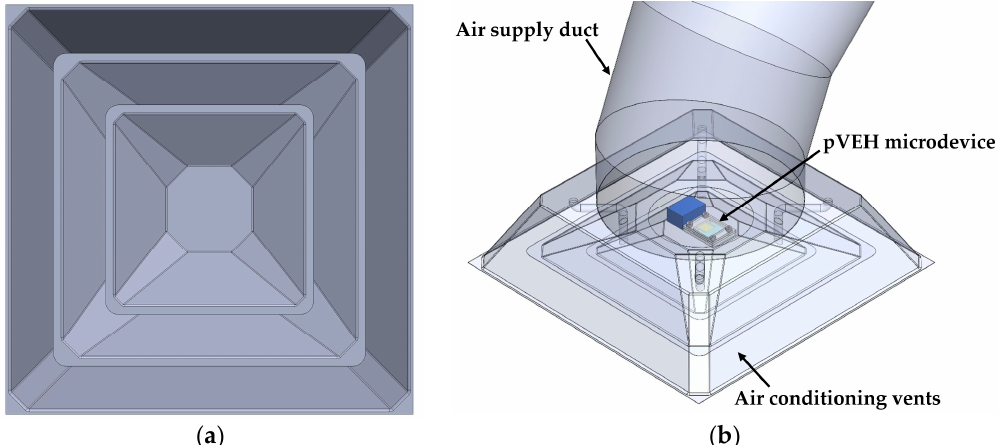
Figure 2. ( a ) Front and ( b ) isometric views of the air conditioning vents at office building with a pVEH microdevice.